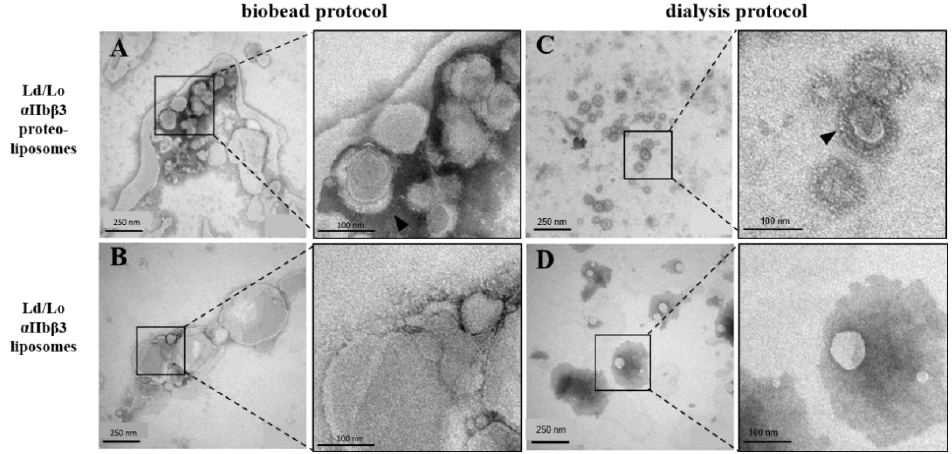
Figure 2. TEM negative stain images of Ld/Lo α IIb β 3 proteoliposomes and empty liposomes containing DOPC:SM:cholesterol (45:35:25 mol%) prepared with different reconstitution protocols. Proteoliposomes (top) and analogously prepared empty liposomes (bottom) were prepared using the ( A , B ) biobead protocol or ( C , D ) dialysis protocol. Densities corresponding to the